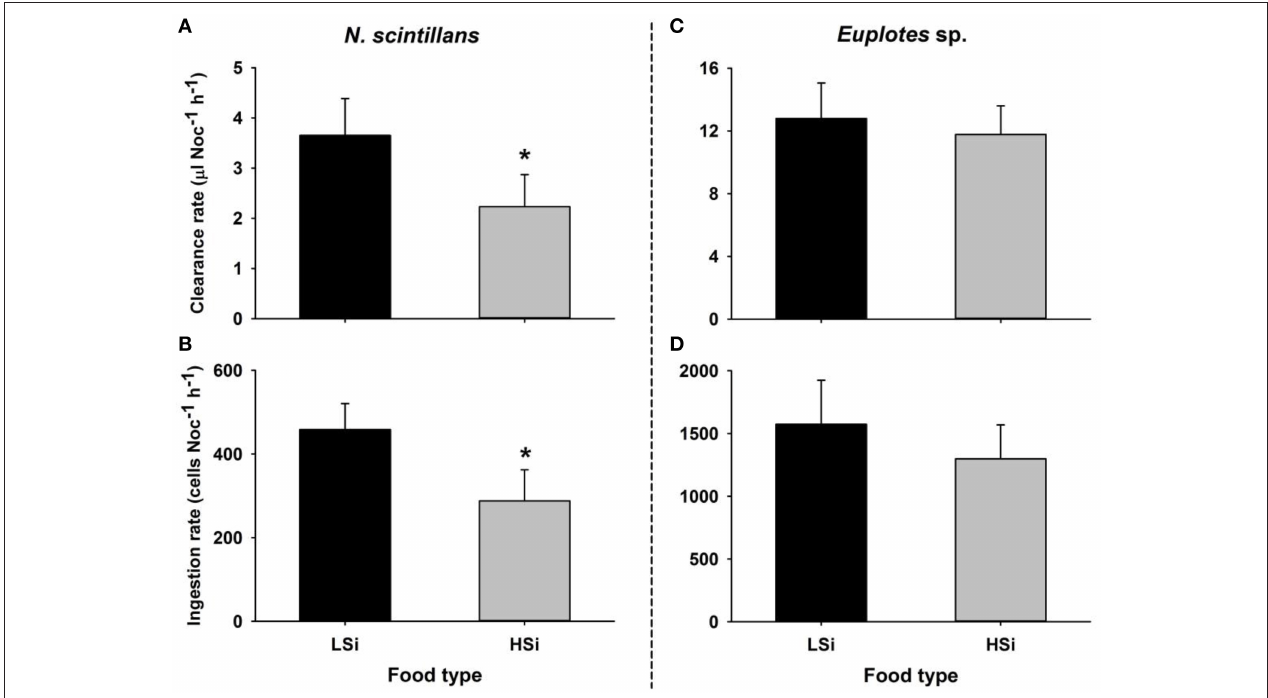
FIGURE 1 | Clearance and ingestion rates of Noctiluca scintillans (A,B) and Euplotes sp. (C,D) on the diatom Thalassiosira pseudonana with different silica contents. LSi and HSi are low and high silica diatom prey, respectively. The error bars show 1 SD ( n = 3). *indicates statistically significant differences at p < 0.05 (Student’s t -test,